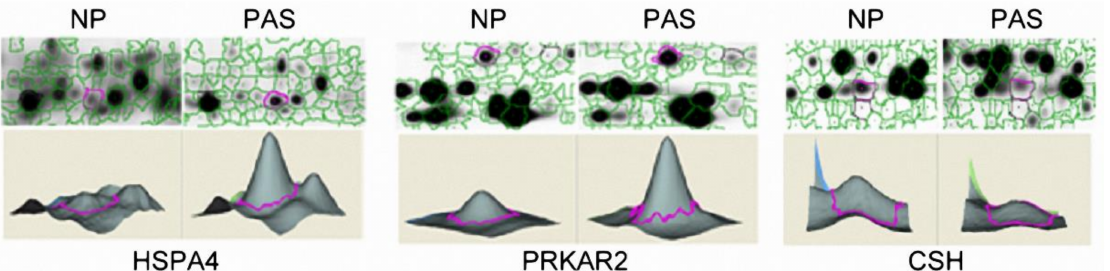
Figure 2. The results of protein quantification with 2D-DIGE. After labeling, the images of gels were scanned in a Typhoon 9400 scanner and further analyzed with Decyder software to quantify protein abundance. HSPA4 and PRKAR2 had higher abundances in PAS tissues, whereas CSH was more abundant in NP tissues.